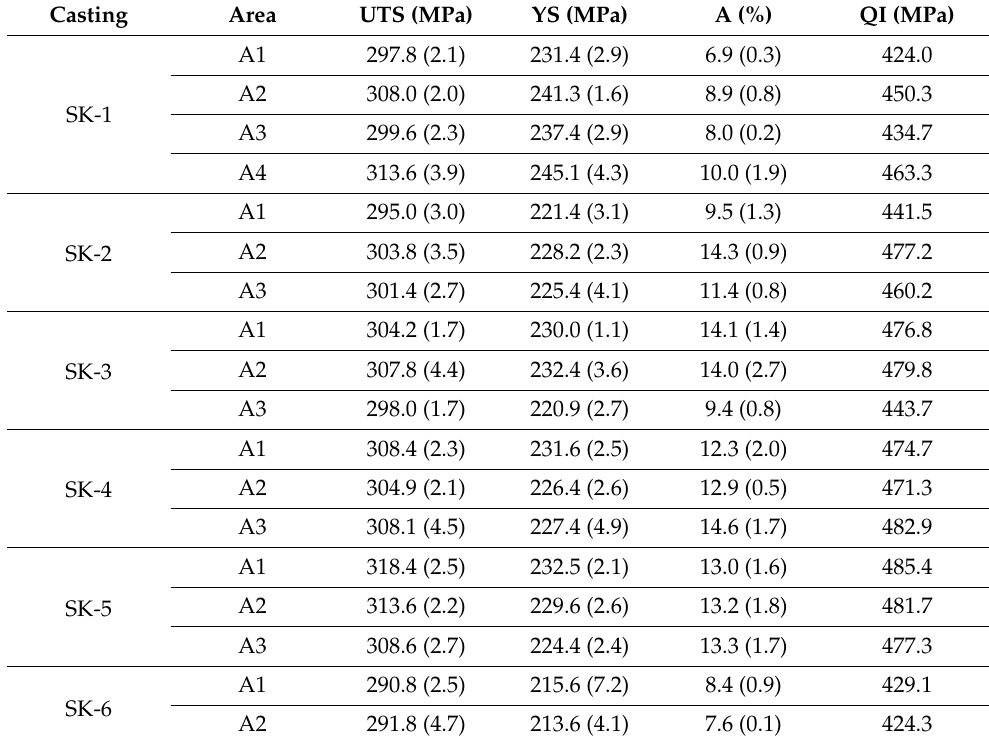
Table 9. Average values of UTS, YS, A and QI for each area analyzed in castings SK-1 to SK-6 (standard deviation values are shown between